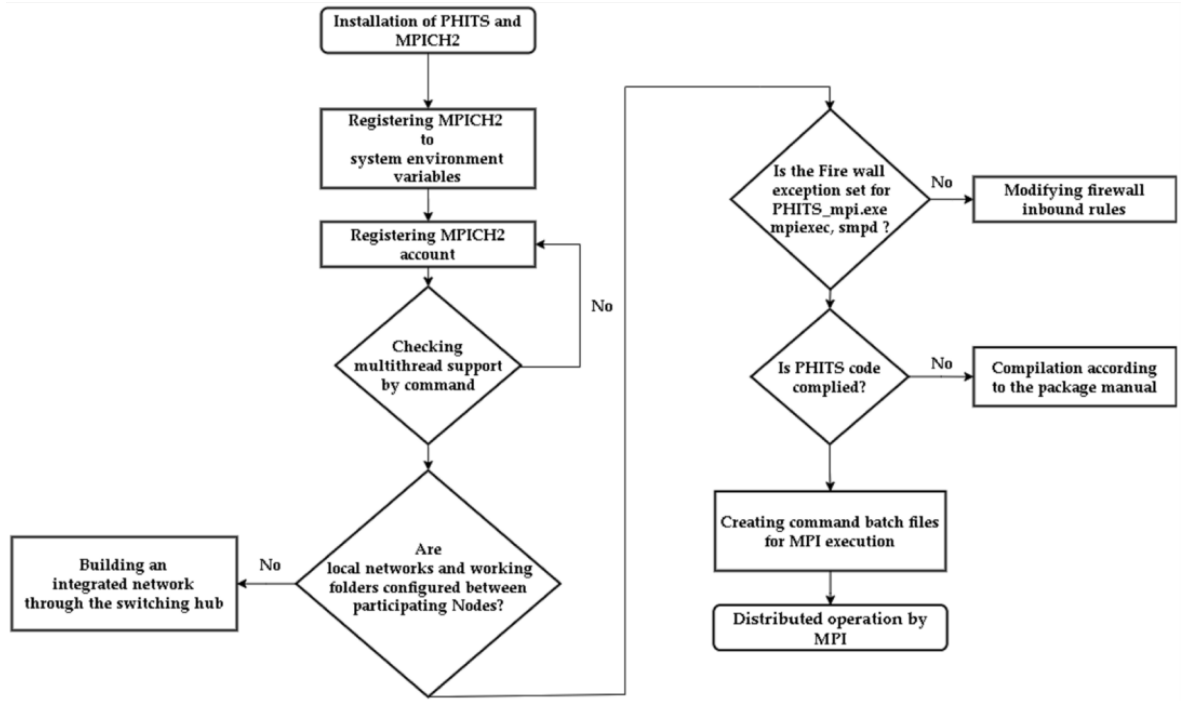
Figure 3. Schematic diagram of PC cluster construction: individual nodes were integrated into one cluster through the processes of (A) MPICH2 installation and registration, (B) local network construction, and (C) PHITS code compilation.